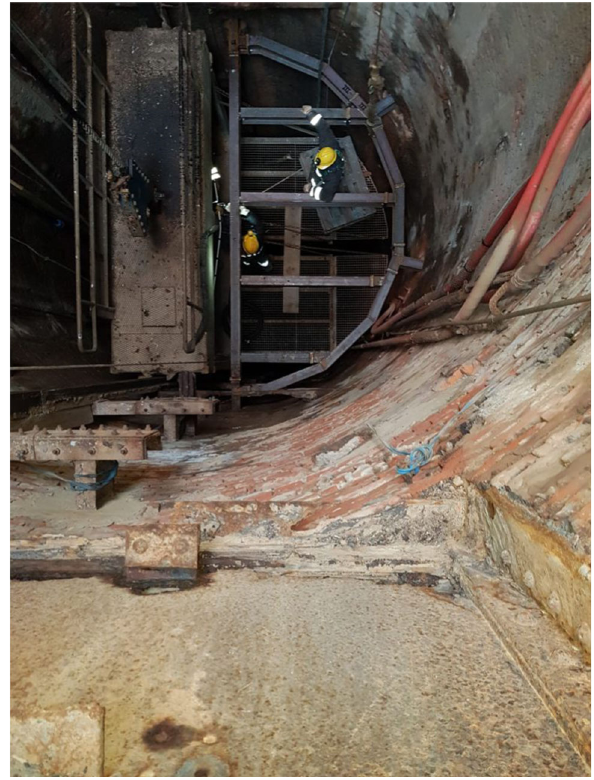
Fig. 9 Installation of the first support structure in the shaft of the Car- bosulcis mine, Seruci